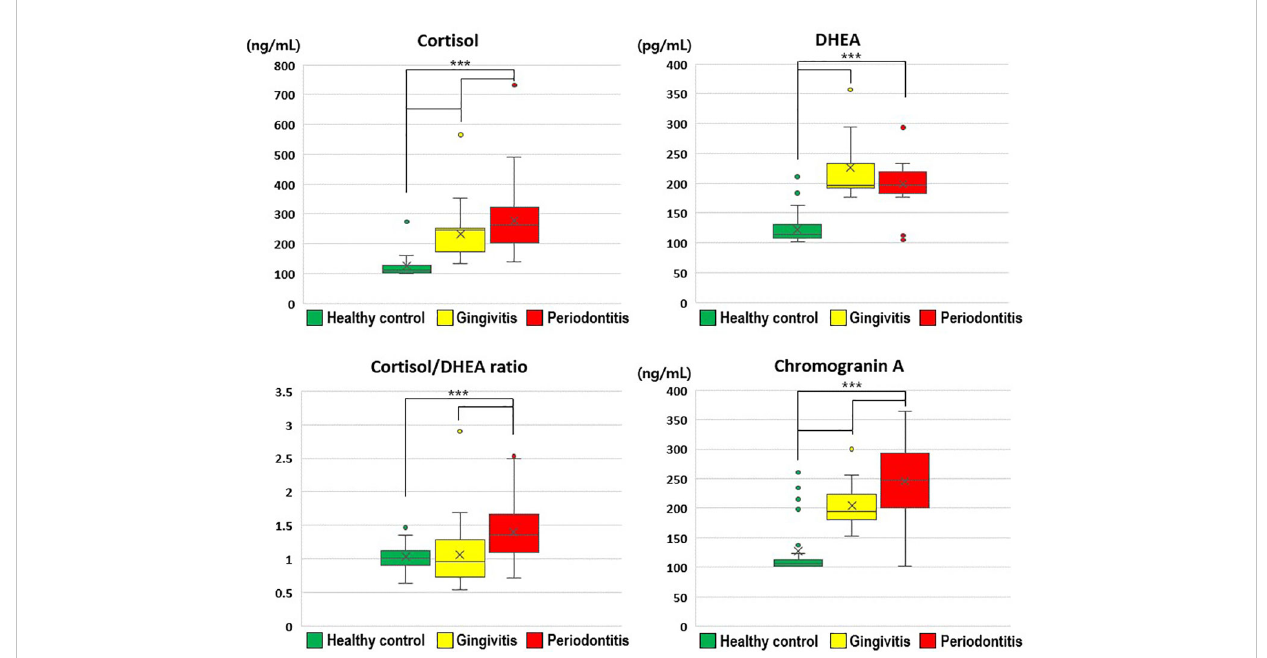
FIGURE 1 Comparisons of cortisol, dehydroepiandrosterone, cortisol/dehydroepiandrosterone ratio, and chromogranin A values by group. The results were obtained from ANOVA and Tukey ’ s paired comparison test. Statistical signi fi cance was set at p < 0.05. ***: p < 0.001. DHEA,